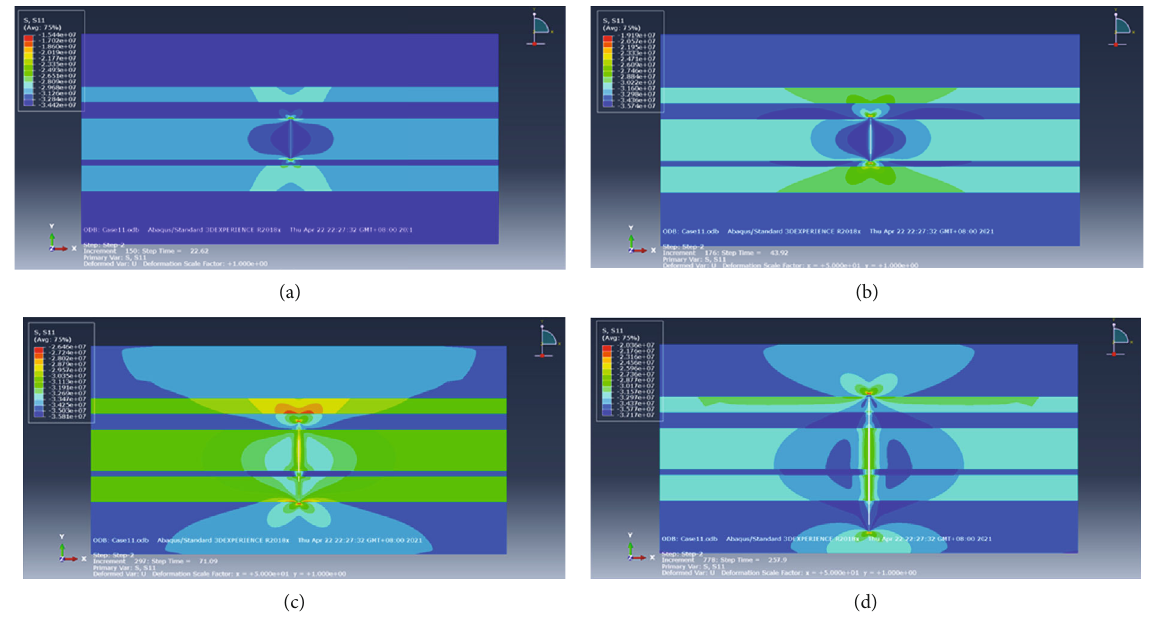
Figure 18: Height growth process in the reservoir with asymmetric mud interlayers: (a) height extends to the fi rst interface, (b) height breaks through the fi rst interface, (c) the lower branch breaks through the mud interlayer and extends to the lower cap, and (d) the upper branch extends to the upper cap.